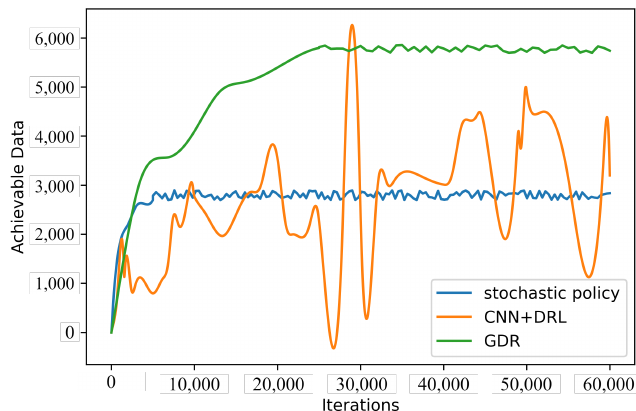
Figure 9. The achievable data rates of the different algorithms.